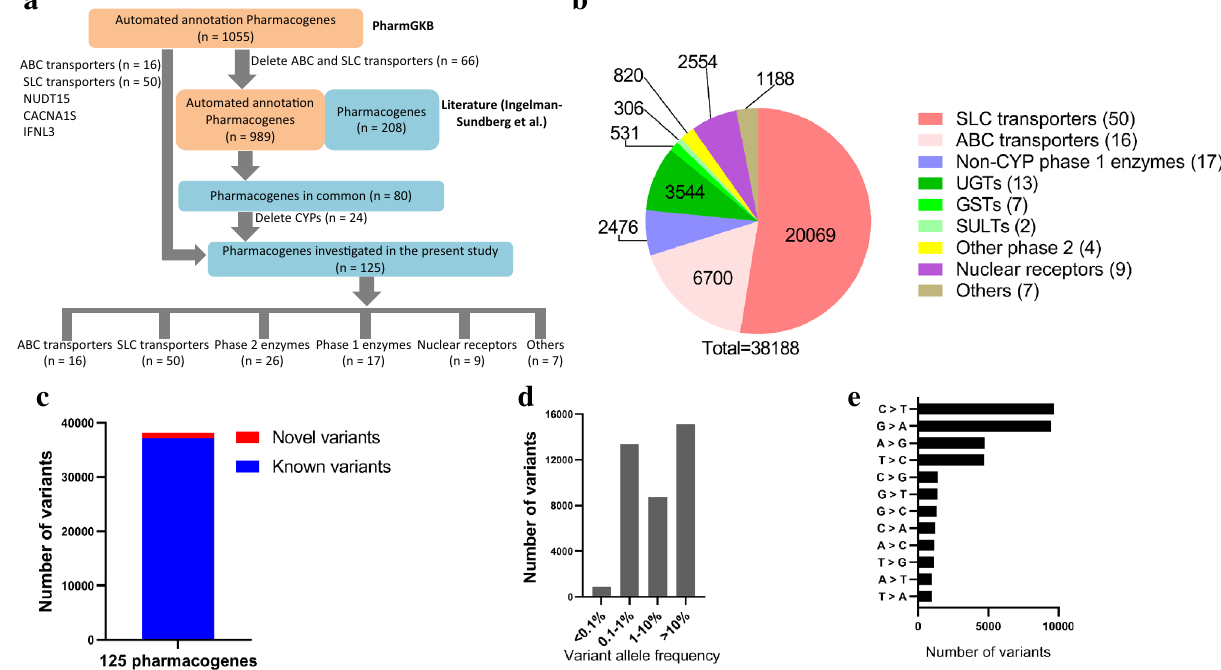
Figure 1. The genetic landscape of 125 pharmacogenes. ( a ) Flowchart of screen of the studied pharmacogenes. ( b ) Pie chart showing the distribution of the identified 38,188 variants among ABC transporters, SLC transporters, non-CYP phase 1 enzymes, phase 2 enzymes, nuclear receptors, and others. ( c ) 1038 (2.7%) of these 38,188 variants we identified were novel as compared to dbSNP release 135. ( d ) Number of variants with different variant allele frequencies. ( e ) Number of variants with different nucleotide mutation